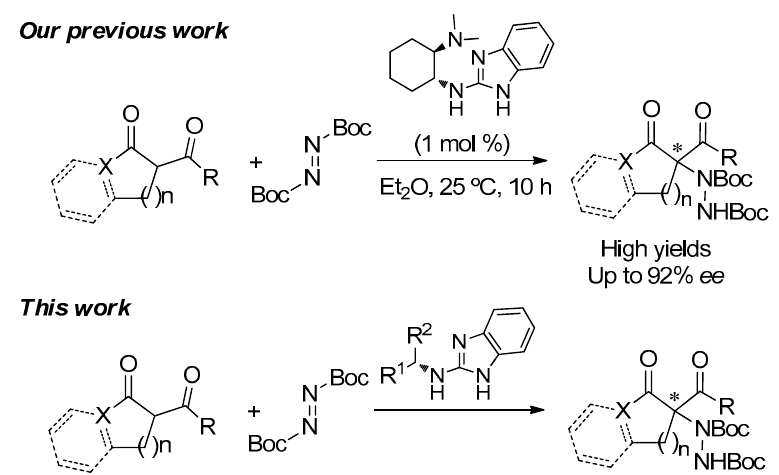
Figure 1. Benzimidazoles-based guanidine organocatalyst in the asymmetric electrophilic aminations of dicarbonyl compounds.